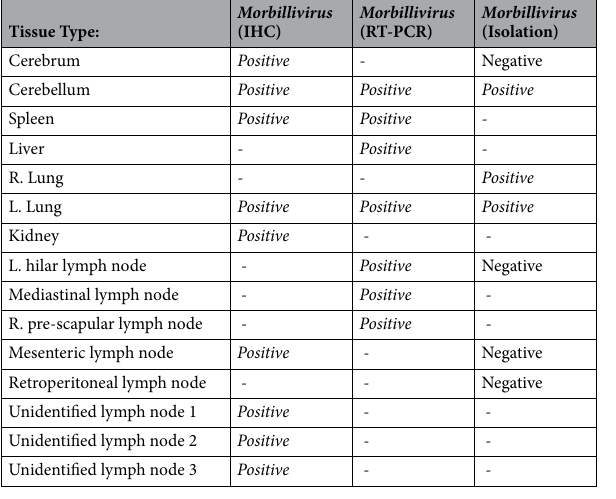
Table 1. Fraser dolphin tissue types tested for the presence of morbillivirus where (-) indicates that the tissue type was not examined.